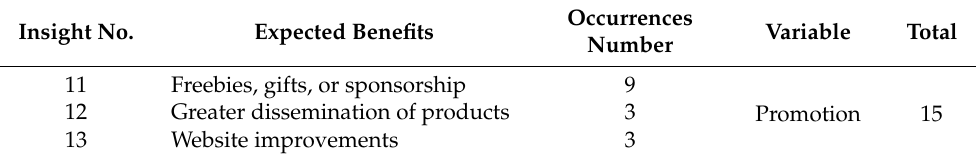
Table 7. Subgroups of comments ranked by the promotion variable. Insight